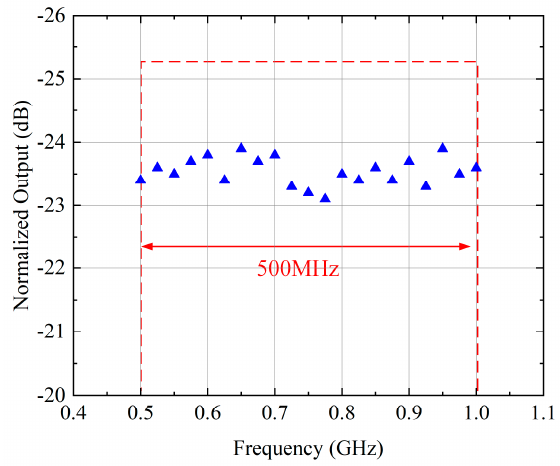
Figure 7. Measured power response of Ch − 8.